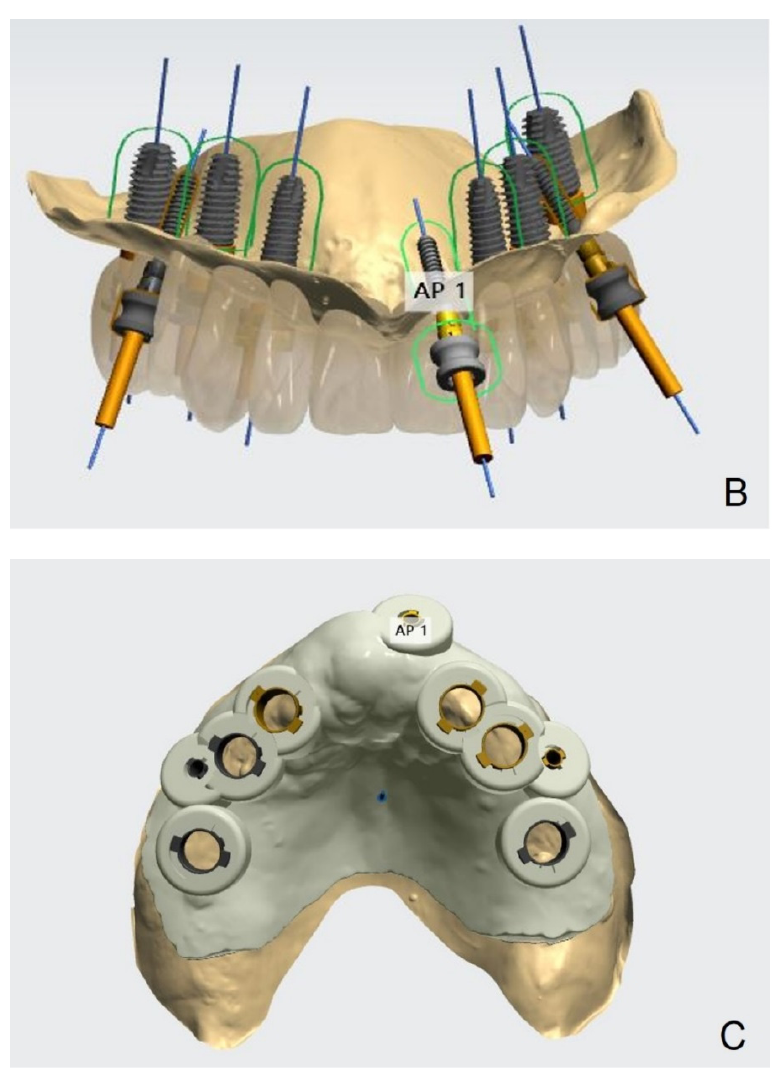
Figure 3. ( A ) Image fusion by matching resin markers present on the intraoral scan and CBCT. ( B ) Virtual implant planning. ( C ) Designed guide for the placement of six dental implants.